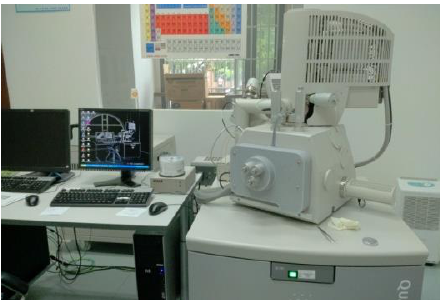
Figure 1. The remolded soil sample.